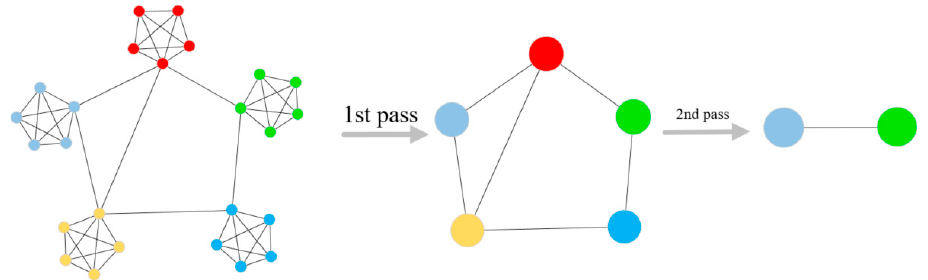
Figure 4. Schematic diagram of multi-level community division based on the Louvain algorithm [28].